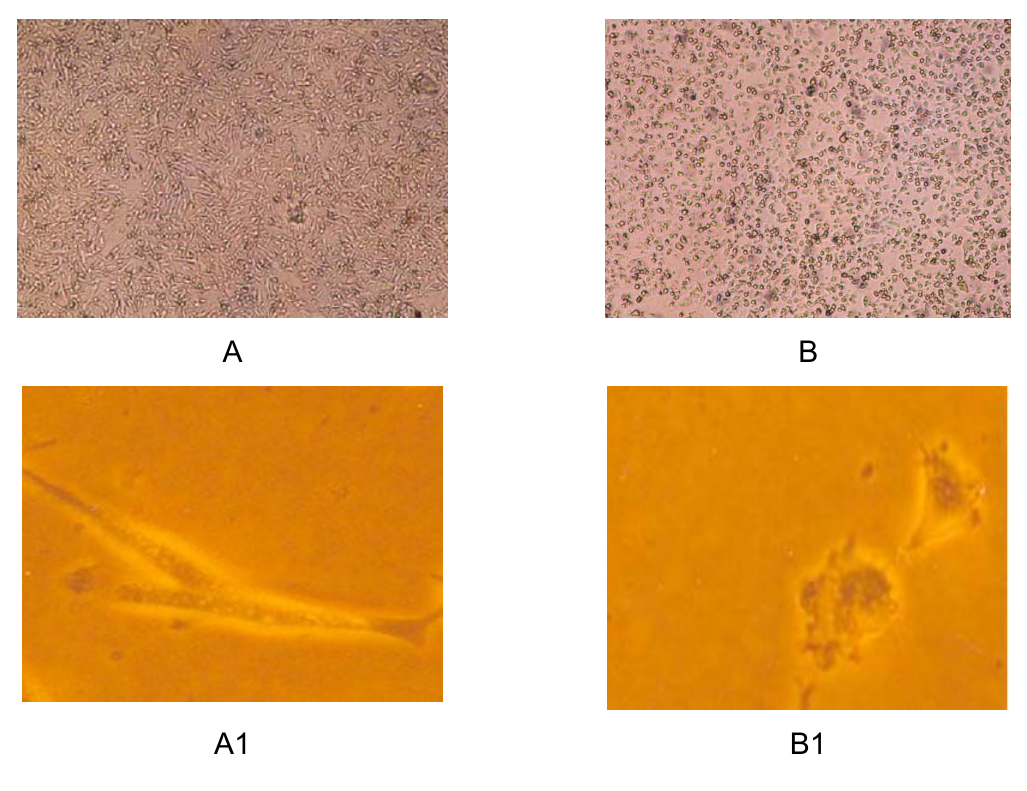
Figure 1. MDA-MB-231 cells before and after treatment with ICD-85. MDA-MB-231 control cells ( A and A1 ); note the normal appearance of elongated cells. MDA-MB- 231 cells treated with 16 µg/mL of ICD-85 ( B and B1 ). Cells present roundish shape and decreased cytoplasmic